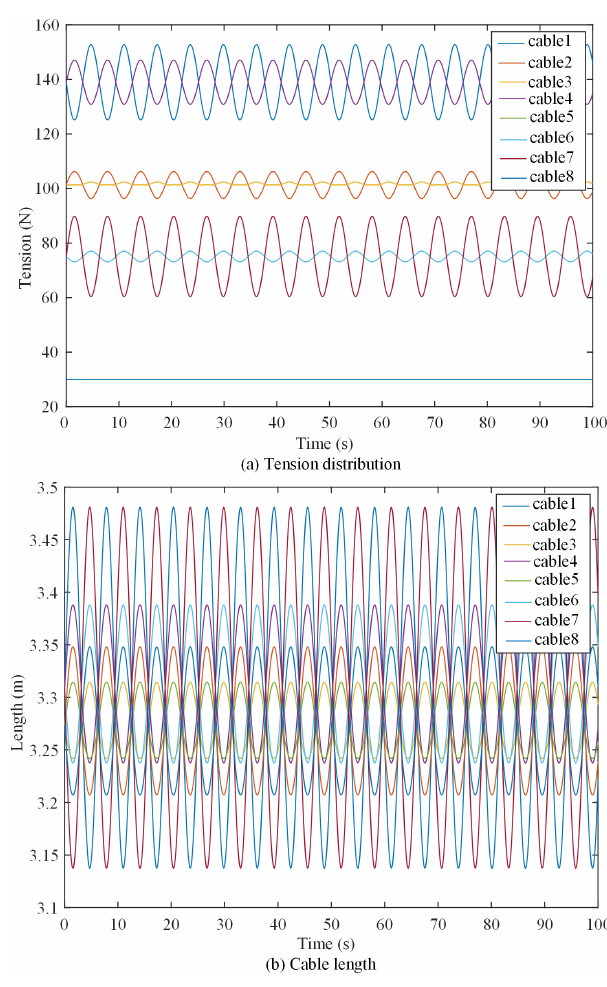
Figure 9. Tension distribution and change in cable length.